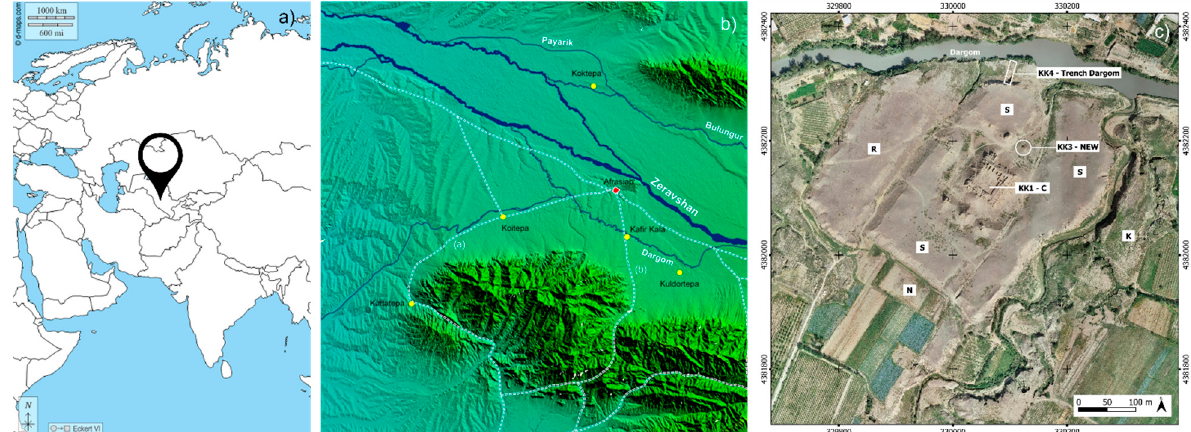
Figure 1. ( a ) location of Uzbekistan (https://d-maps.com/carte.php?num_car=54&lang=it; accessed on 31 October 2021); ( b ) main Silk Road local routes in the Samarkand region (basemap: ASTER GDEM 2013, © UIAP 2015); ( c ) aerial view of the archaeological complex of Kafir Kala with the main excavated areas (drone acquisition and data processing by G. Luglio, © UIAP 2018).